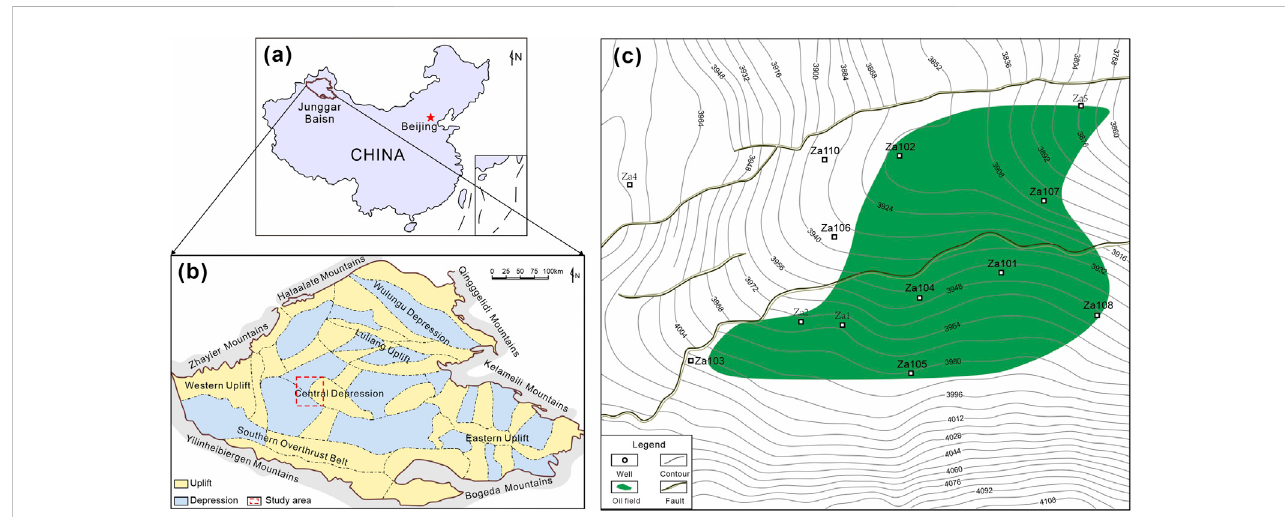
FIGURE 1 Regional tectonic position in the study area. (A) The location of the Junggar Basin. (B) The subdivisions of the Junggar Basin and the location of the Moxizhuang area. (C) The well locations in the Moxizhuang area. The green area shows the oil fi eld.